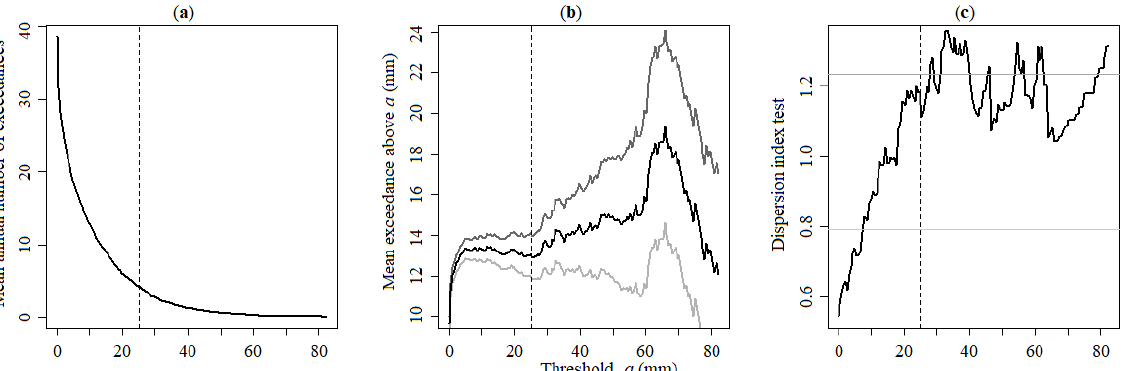
Figure 5. Peaks-over-threshold sampling technique applied to daily rainfall at the Lisboa-Geofísico station from 1 October 1864 to 30 September 2021: ( a ) mean annual number of over-threshold events; ( b ) mean exceedance over the threshold; and ( c ) dispersion index. 95% confidence bands are identified in grey scale, and the selected threshold a = 25 mm by dashed vertical lines.